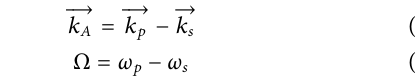
Frontiers in Physics |